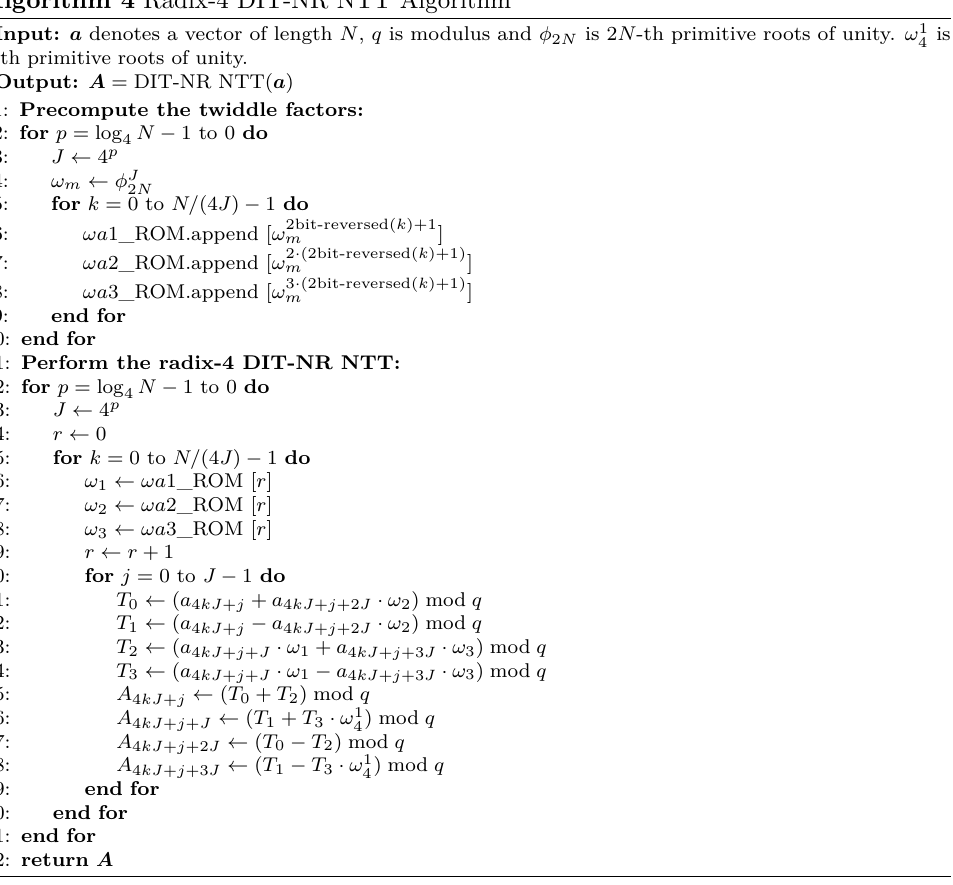
Algorithm 4 Radix-4 DIT-NR NTT